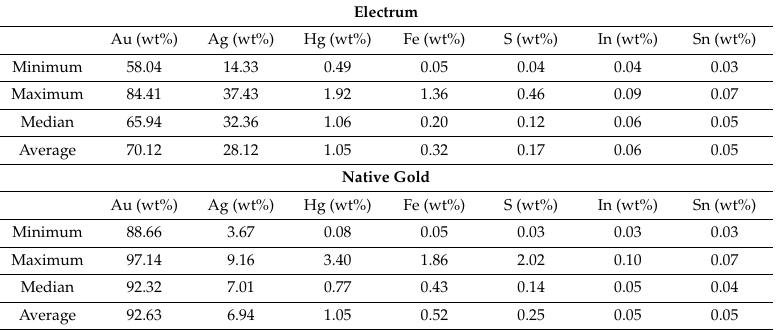
Table 1. Summary of statistical electron microprobe (EMP) analyses (wt%) from native gold and electrum from Mollehuaca and San Juan de Chorunga, Arequipa-Peru. (nAu = 87; nelectrum = 20). Electrum Au (wt%) Ag